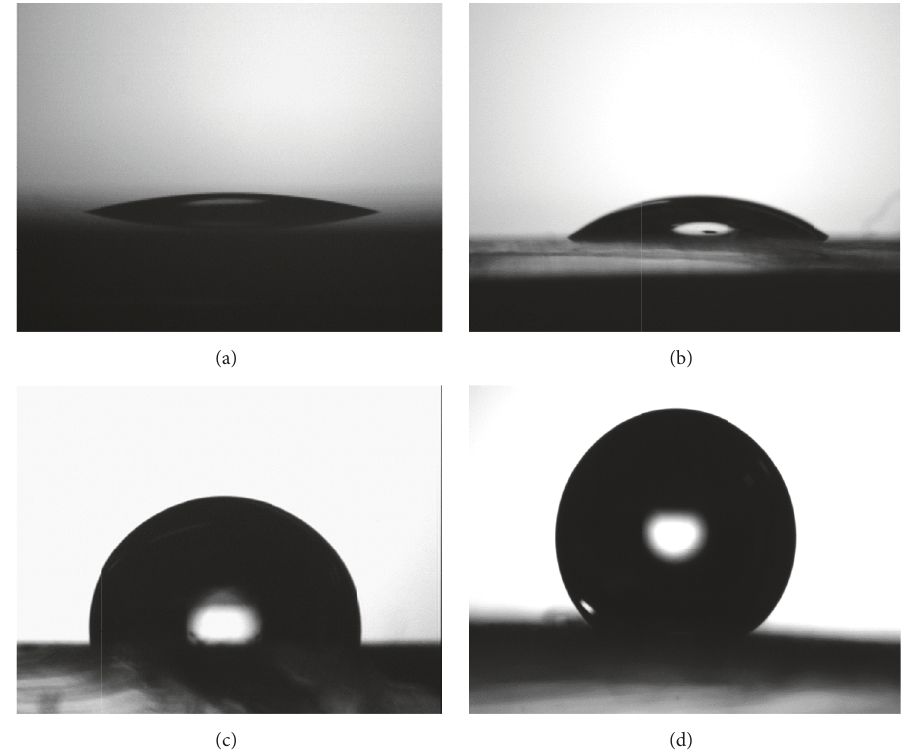
Figure 1: 5 𝜇 l drop of water (a) on glass substrate (treated with Piranha solution), (b) on nontreated glass substrate, (c) on polystyrene (PS) substrate, and (d) on hydrophobic TEFLON